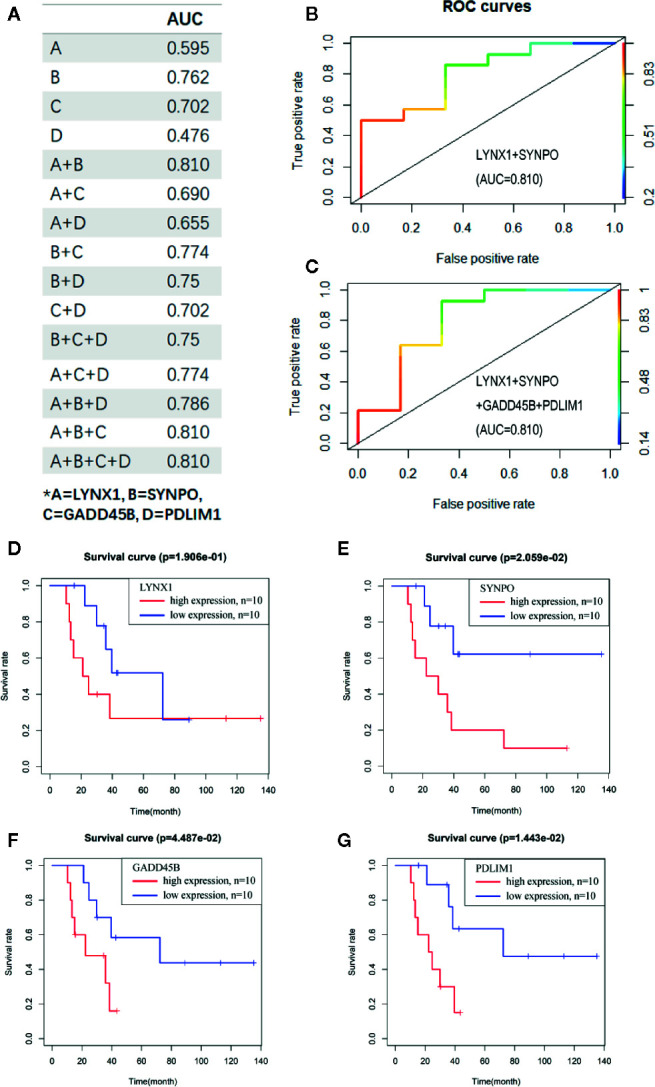
The persister-gene panel acts as an indicator of poor clinical outcome of radiotherapy in NSCLC. (A) AUC values of the combined persister genes in ROCs for estimating them as indicators of radio-resistance. ROCs were constructed with Logistic regression model. (B, C). The best AUC values were shown as the combination of LYNX1 and SYNPO, as well as the four-gene group. (D–G). Survival curve of LYNX1, SYNPO, GADD45B, and PDLIM1, according to the Kaplan–Meier analysis. Red/blue lines indicate high/low expression of the corresponding genes.